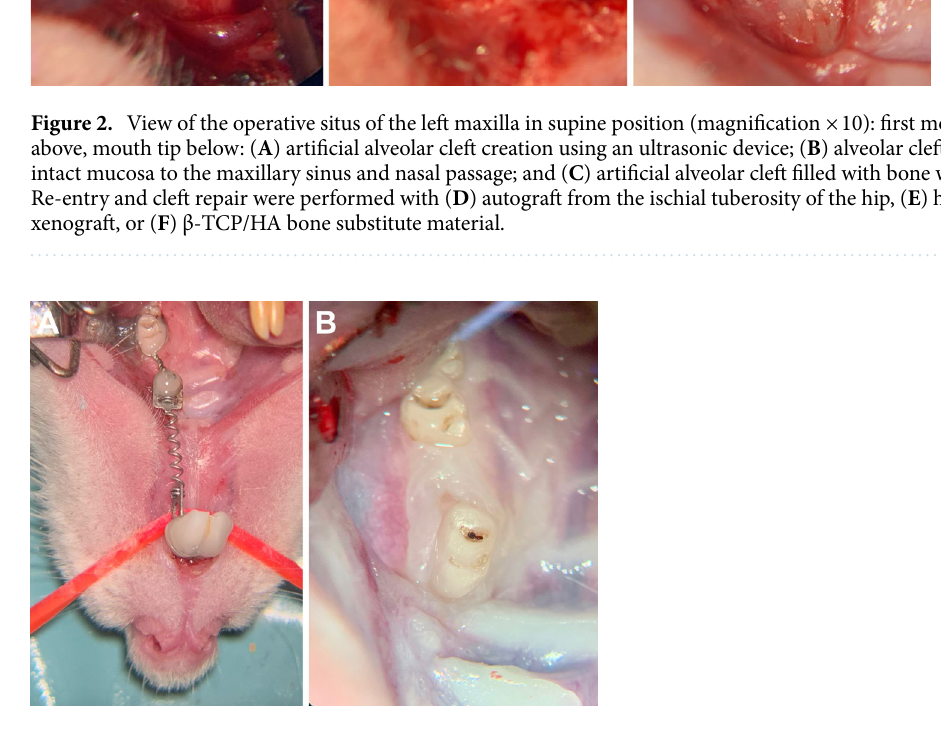
and 2 days before (T2) and 7 days (T3) after orthodontic-appliance installation, the rats were imaged with an